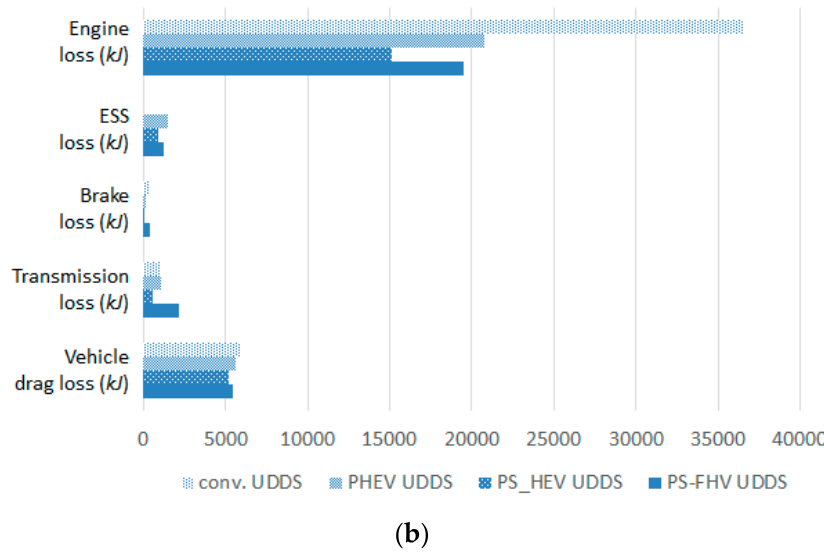
Figure 26. Comparing energy loss between the PS-FHV and other powertrain types; ( a ) UDDS driving cycle; and ( b ) HWFET driving cycle.